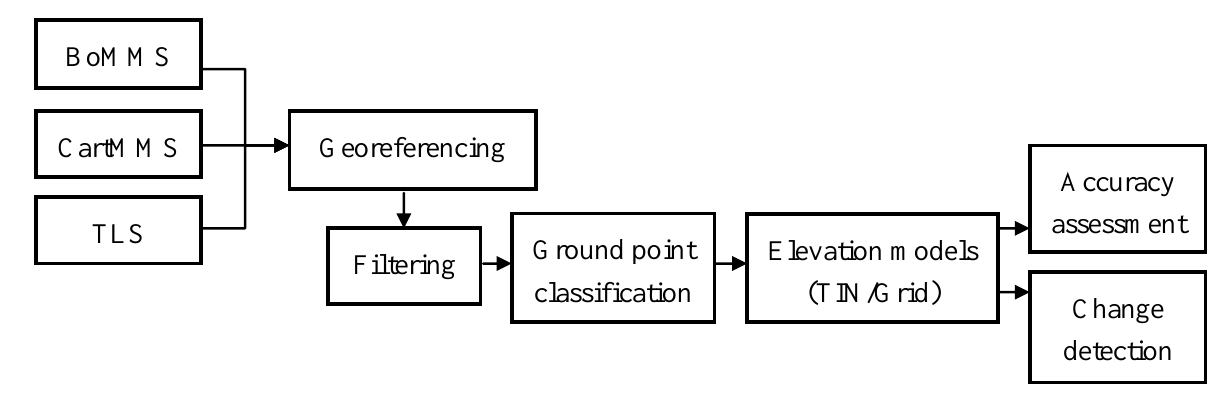
Figure 3. The processing chain for point cloud